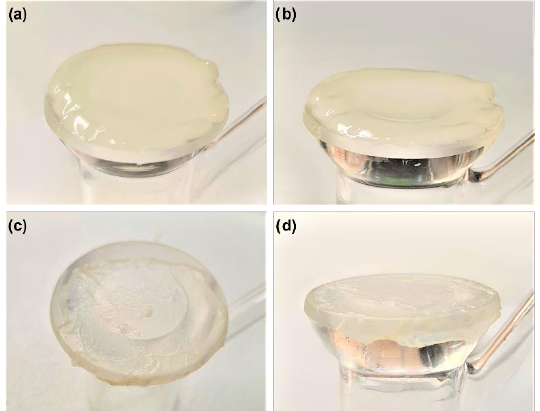
Figure 8. Pictures of control BASS ( a , b ) and treated BASS ( c, d ) on day 16 of BASS evaluation. Pictures taken from above ( a, c ) and the side ( b, d ) for better comparison. Treated BASS is thinner and more translucent compared to control